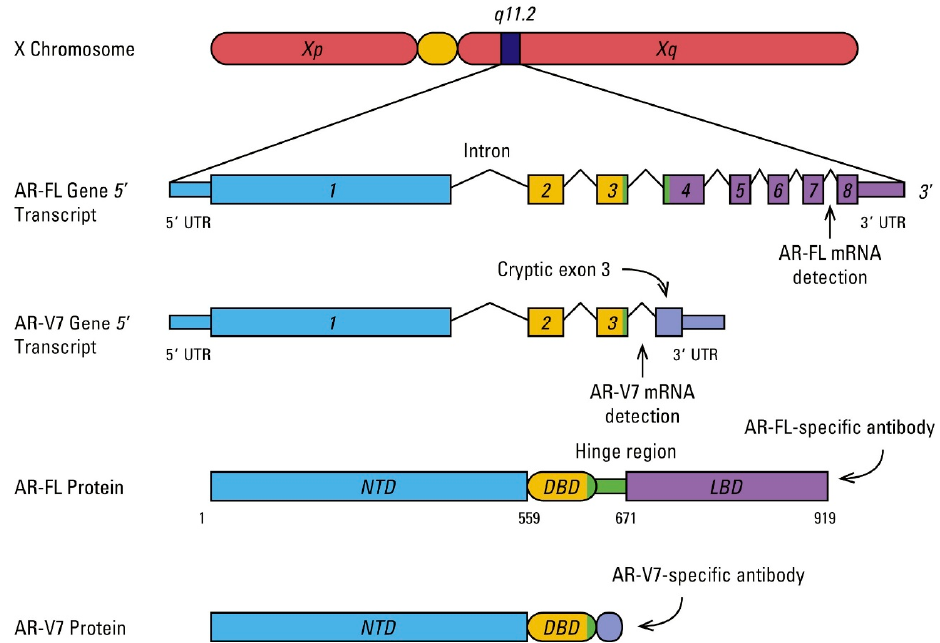
Figure 1. Transcript structures for full-length androgen receptor (AR) and the splice variant AR-V7. Peptide positions are marked according to GRCh36/hg18 human genome sequences (not drawn to scale). Reproduced, with permission, from Luo J. Development of AR-V7 as a Putative Treatment Selection Marker for Metastatic Castration-Resistant Prostate Cancer. Asian J. Androl. 2016 , 18 , 580–585; Licensed under a Creative Commons Attribution 4.0 Unported License (Available at https://creativecommons.org/licenses/by/4.0/). Abbreviations: AR-FL, full-length androgen receptor; DBD, DNA-binding domain; LBD, ligand-binding domain; mRNA, messenger RNA; NTD, N-terminal domain; UTR, untranslated region.